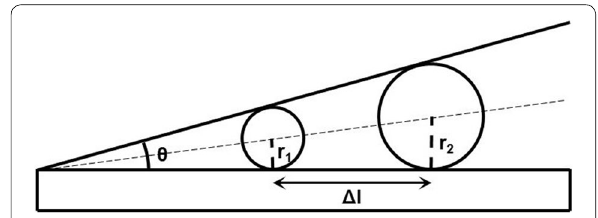
Fig. 3 Geometric constraints on approach to CL by NPs of different sizes. The NPs are sorted by